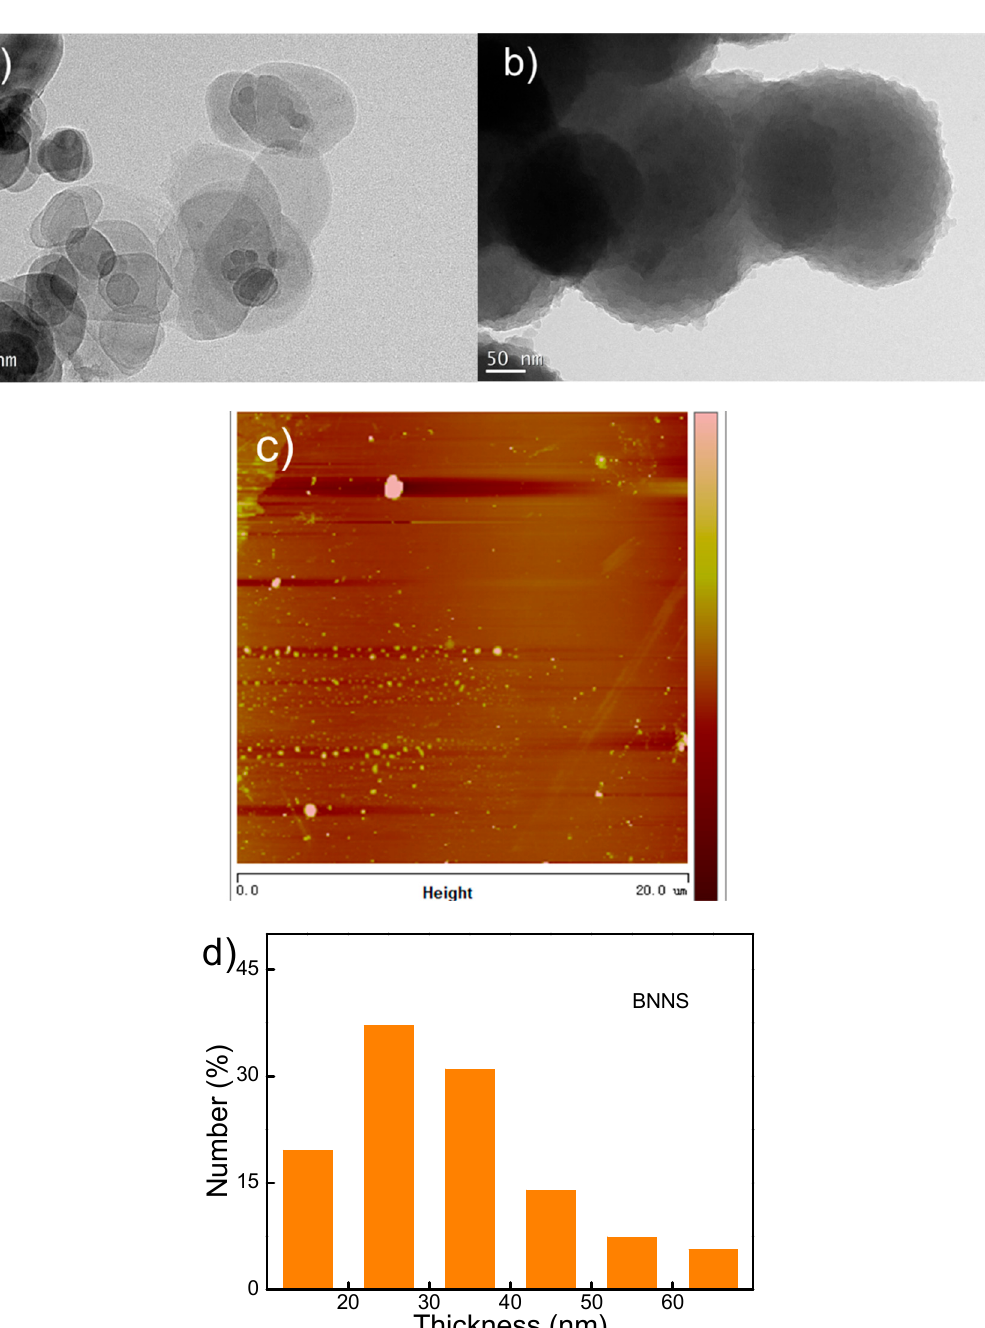
Figure 3. Transmission electron microscopy (TEM) images for ( a ) BNNS and ( b ) m BNNS particles, respectively, ( c ) AFM image and ( d ) the histogram for BNNS.